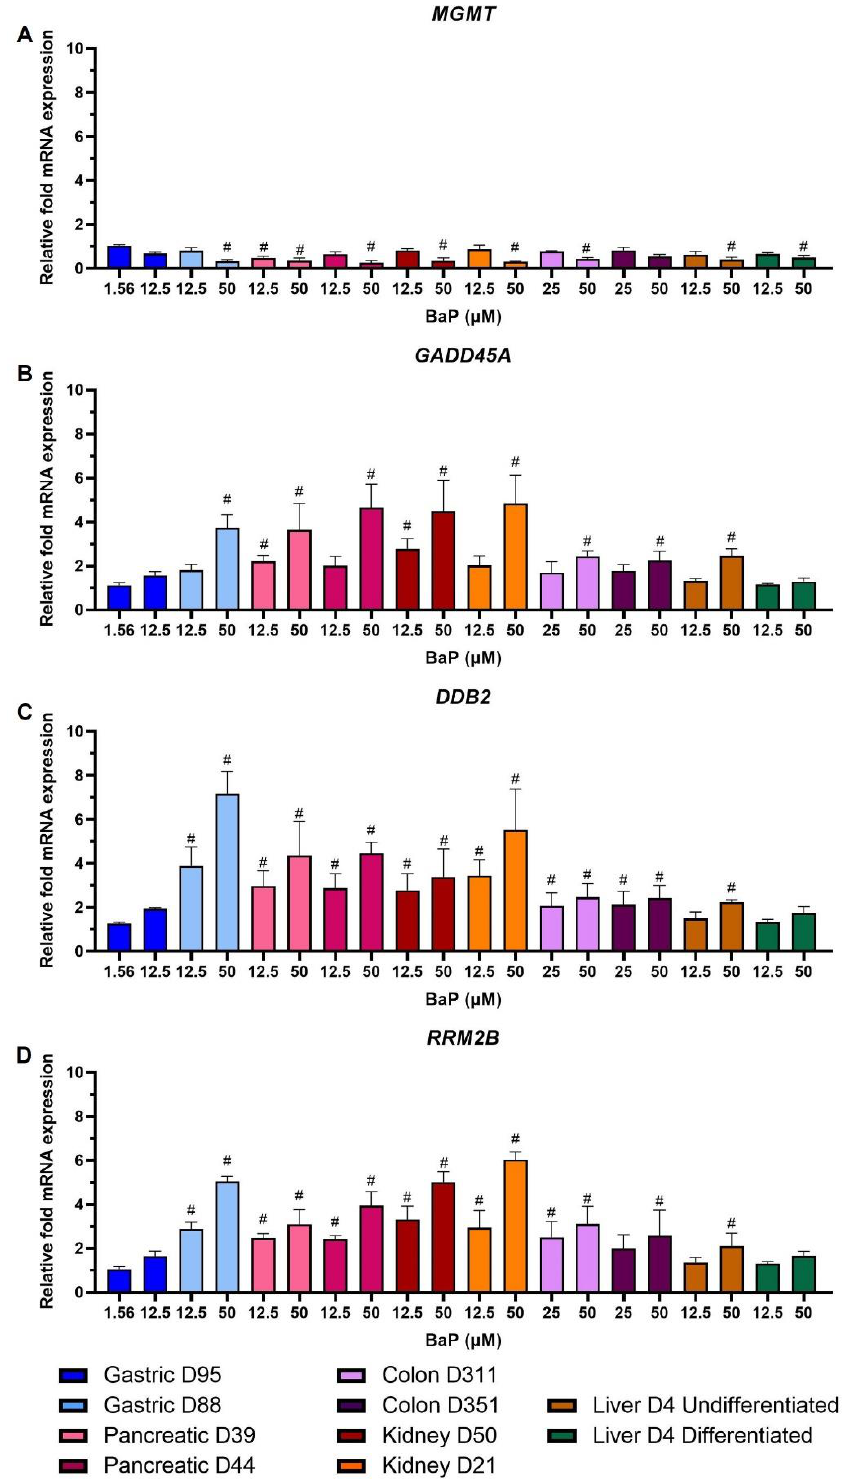
Figure 6. Effects of BaP on gene expression related to DNA damage response and repair. Human tissue organoids were treated with the indicated BaP concentrations for 48 h. Gene expression changes were measured by HT RT-qPCR. Linear fold-changes for ( A ) MGMT, ( B ) GADD45A, ( C ) DDB2 and ( D ) RRM2B are shown as mean ± SD (n = 3). Log2 values ±1 were considered biologically relevant (#), compared to the vehicle control (0.5% DMSO).